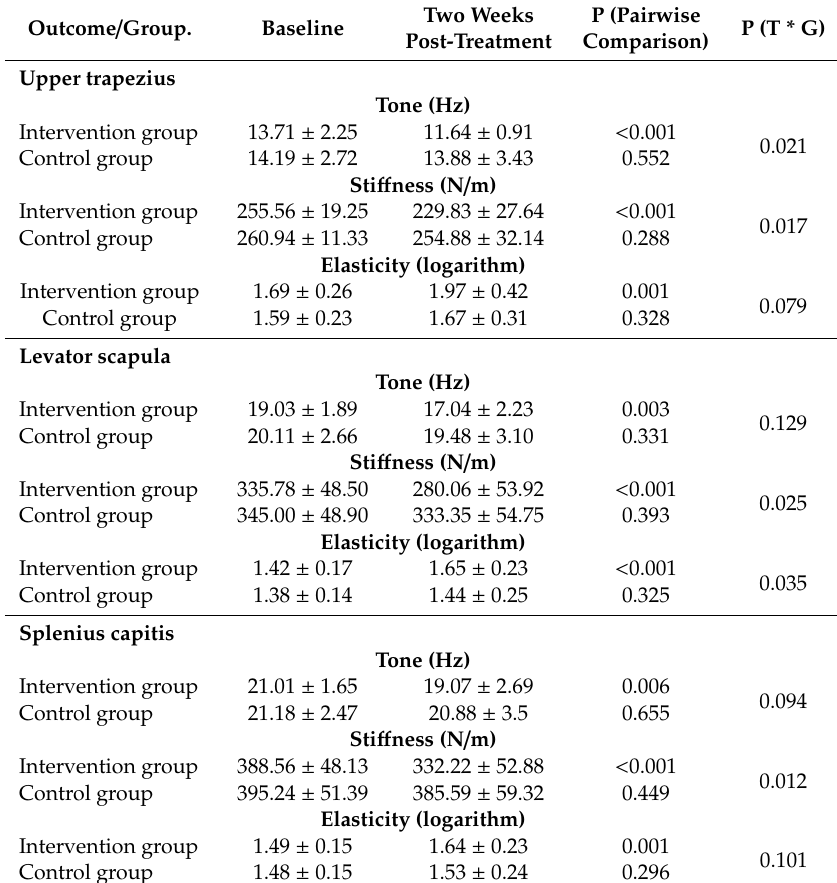
Table 3. The changes in muscle characteristics.